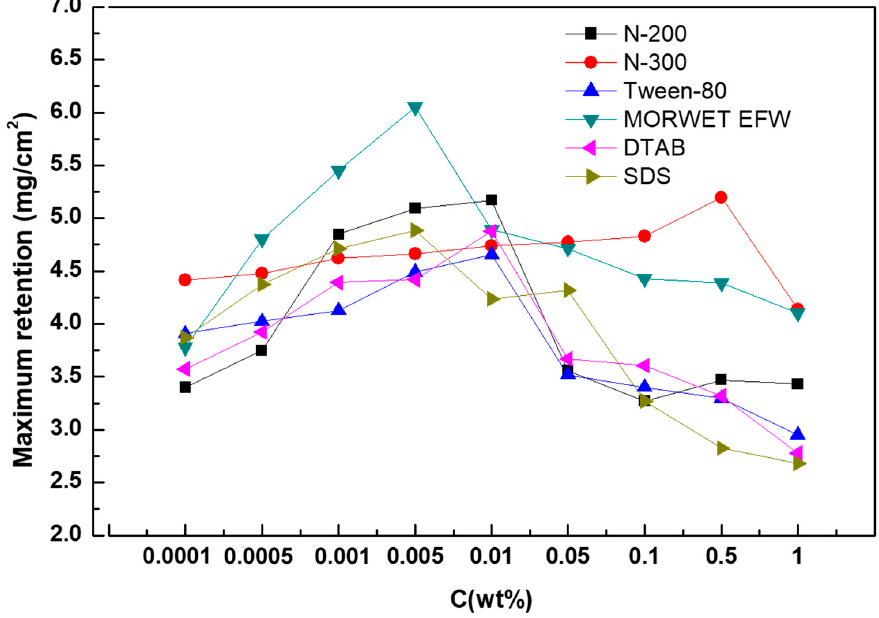
Figure 11. Dependence of the maximum retention of aqueous surfactant solutions on tea leaf surfaces.